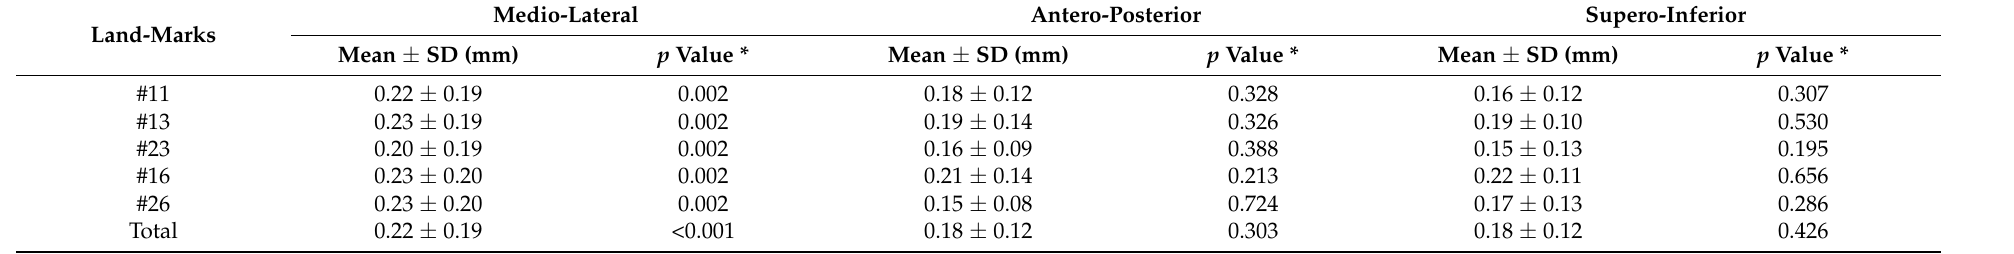
Table 3. Displacement of the mobilized maxilla during fixation based on intraoperative